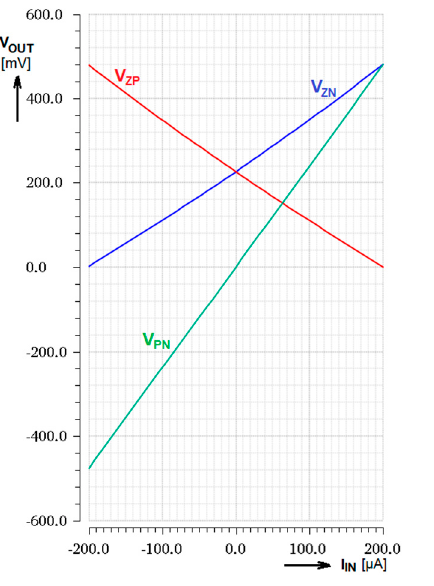
Figure 3. Slightly simplified schematic of the input and transimpedance stage.